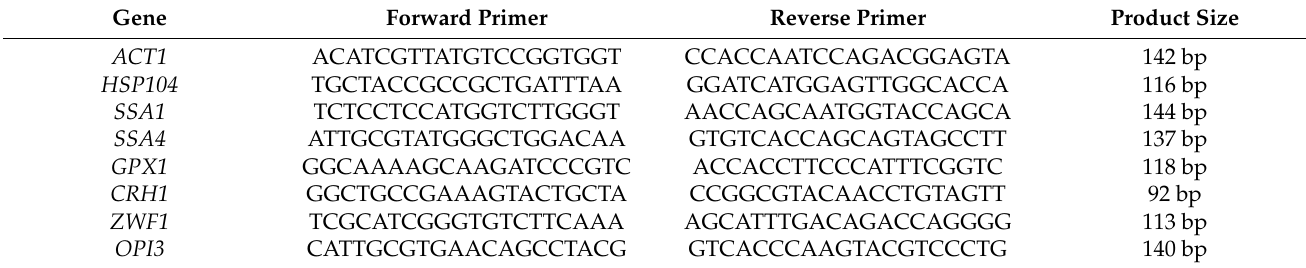
Table 2. Primers used in this